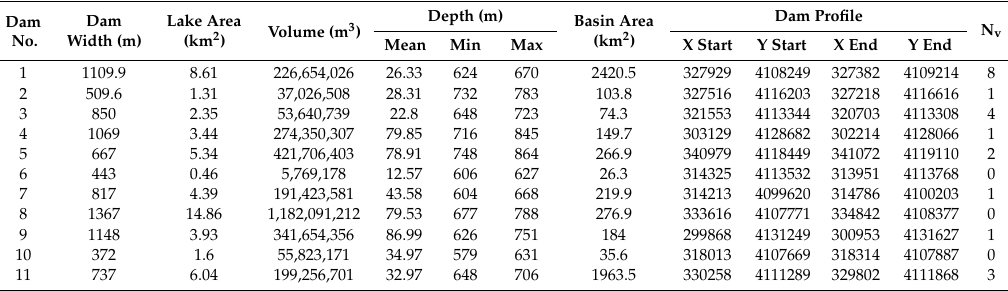
Table 6. Characteristics of the suggested dam sites. Dam